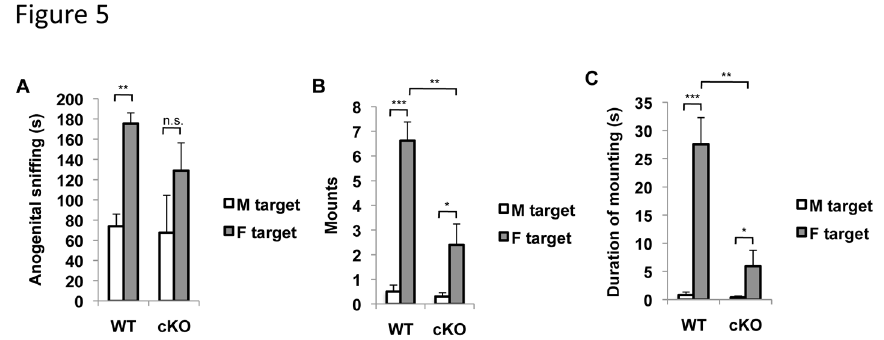
Figure 5. ERK5 deletion does not alter the mating choice of male mice. The mating choice assay was performed by introducing an estrous female and a male target mouse simultaneously into the home cage of the test male mouse. An ovariectomized female mouse was injected with estradiol and progesterone to achieve estrous status and used as the female target. The male target was a castrated male mouse odorized with the urine from normal male mice. Both investigative (sniffing) and sexual (mounting) behaviors were quantified. A , Time spent in anogenital sniffing. B , Number of mounts. C , Duration of mounting. n.s., not significant; *, p<0.05; **, p<0.01; ***, p<0.001. doi: